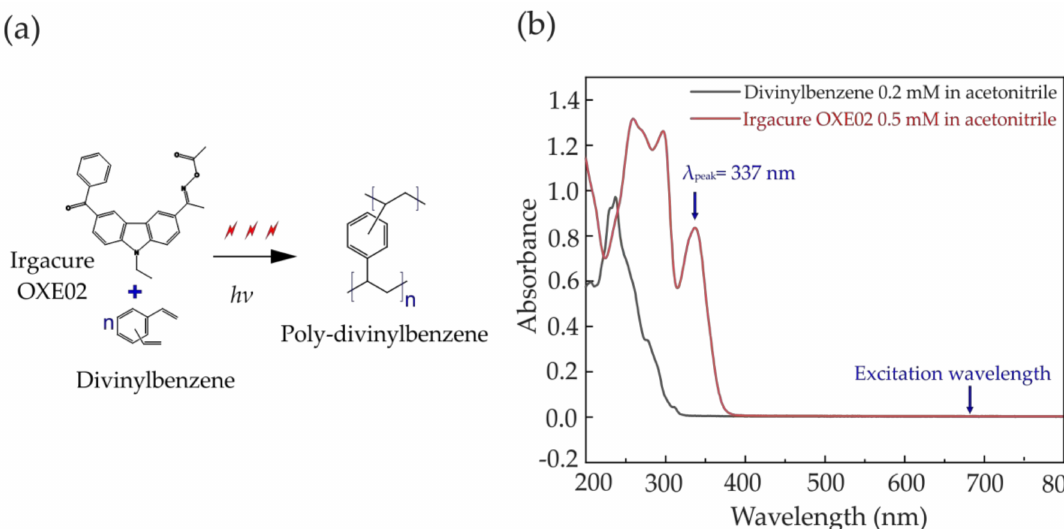
Figure 1. ( a ) Molecular structure of the divinylbenzene (DVB) monomer and Irgacure OXE02 and the polymerization of the monomer upon laser irradiation; ( b ) Absorption spectrum of 0.2 mM DVB and 0.5 mM Irgacure OXE02 in acetonitrile. Blue arrows indicate the absorption wavelength peak of the photoinitiator (PI) (337 nm) and the excitation wavelength of our system tuned to 680